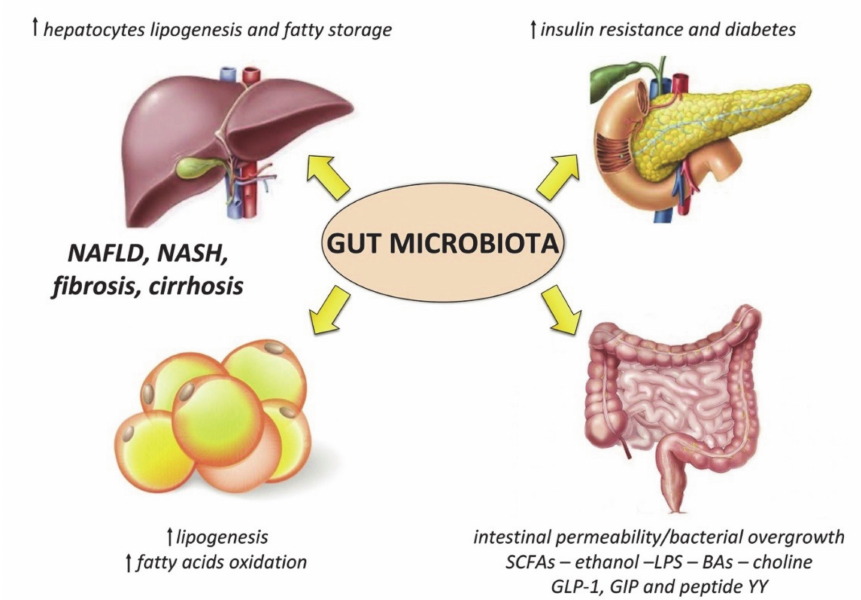
Figure 2. Mechanisms linking the gut microbiota to metabolic derangement in obese patients. Short chain fatty acids (SCFAs) derived from bacteria metabolism also influence lipid metabolism by increasing lipogenesis in the liver and in the adipose tissue, and inhibiting fatty acids oxidation; together with bile acids (BAs), SCFAs can modulate host appetite and insulin release through the secretion of gastrointestinal incretins (i.e., glucagon-like peptide 1 (GLP-1), and gastrointestinal insulinotropic polypeptide (GIP) and peptide YY), as well as the activation of the farnesoid X receptor (FXR). Choline depletion due to bacteria utilization also contributes to liver lipid accumulation, as well as the reduction of fasting-induced adipocyte factor (FIAF). LPS is another important modulator of glucose metabolism and insulin sensitivity. These alterations, associated with the increased intestinal permeability and bacterial overgrowth typical of obesity, as well as endogenous ethanol production by the gut microbiota, contribute to liver inflammation leading to non-alcoholic steatohepatitis (NASH) and